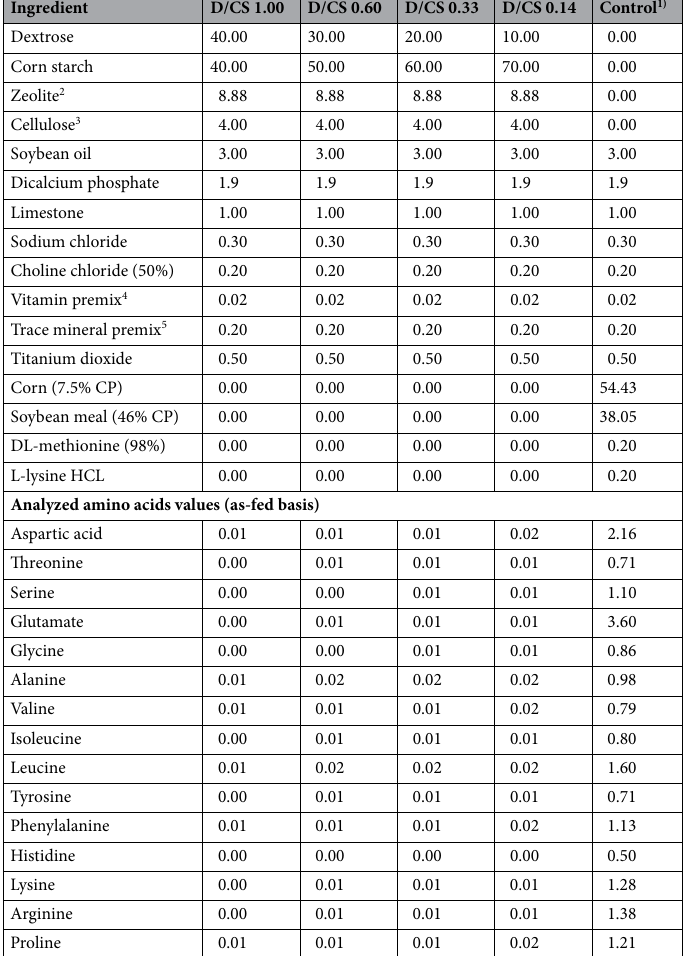
Table 1. Ingredient composition and amino acids levels of NFD and control diets (%). 1 Nutrient level of the control diet: Metabolizable energy 2.95MC/kg, Crude protein 22.50%, Ca 1%, non-phytate phosphorous 0.45%. 2 The zeolite (Deheng mineral products Co., Ltd, Shijiazhuang, China) was used as premix carrier in the NFD diets, it contains almost no protein, energy or any other digestible nutrients. 3 Sodium carboxymethyl cellulose (CAS: 9004–32-4, Sinopharm Chemical Reagent Co., Ltd, Shanghai China). 4 Premix vitamin provides per kg of diet: Vitamin A, 10,800 IU; Vitamin D3, 2160 IU; Vitamin E, 4.6 mg; Vitamin K3, 1.0 mg; Vitamin B1, 0.4 mg; Vitamin B2, 5 mg; Vitamin B12, 6 mg; folic acid, 0.1 mg; niacin, 7 mg; pantothenic acid, 5 mg. 5 Trace mineral premix provides per kg of diet: Cu, 6 mg; Zn, 50 mg; Fe, 60 mg; Fe, 0.15 mg; I, 0.35